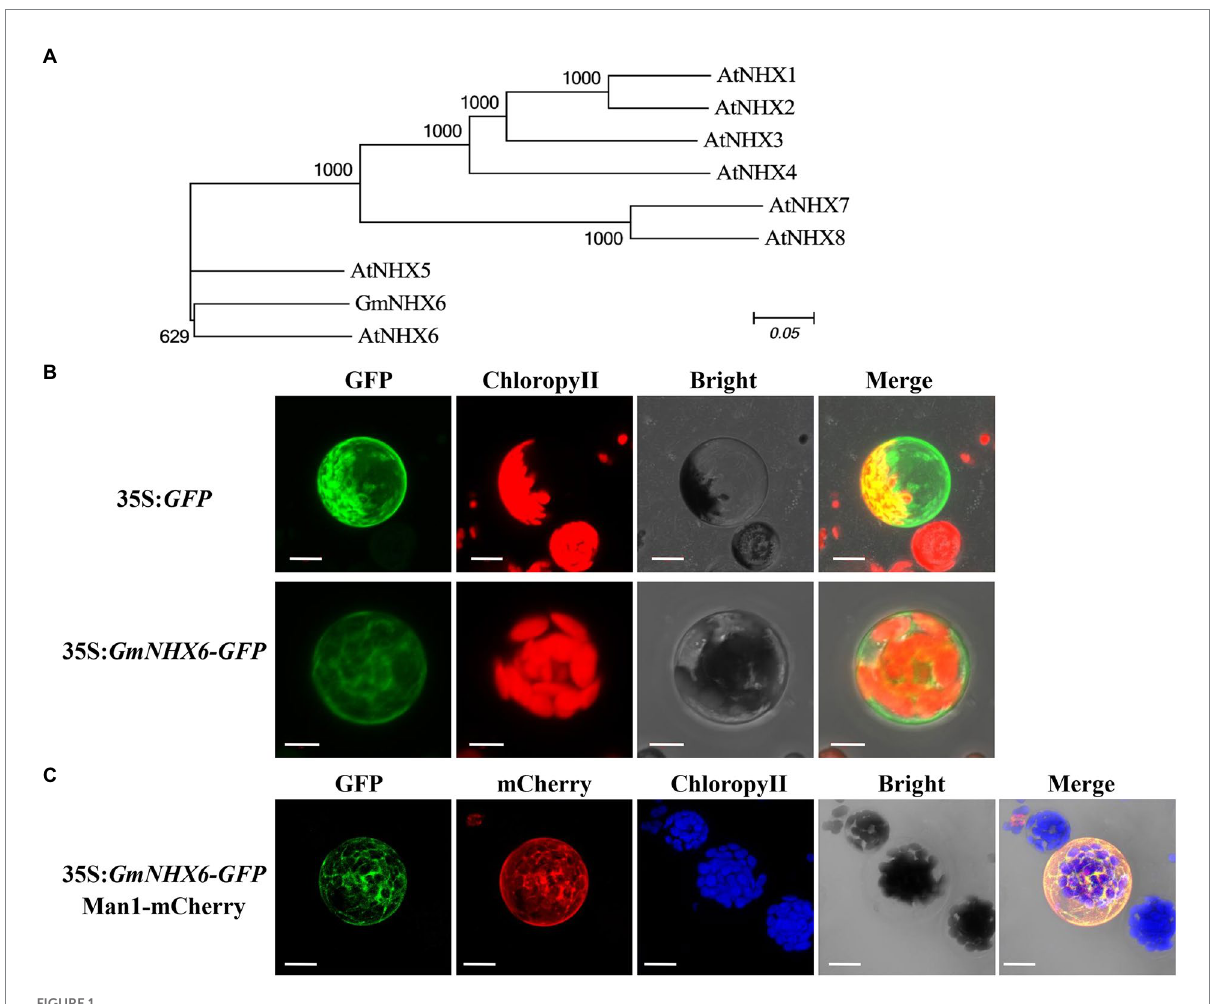
FIGURE 1 Phylogenetic analysis and subcellular localization of GmNHX6. (A) Phylogenetic analysis of GmNHX6 (XP_028181010.1) from soybean Glycine max and NHX proteins from Arabidopsis thaliana including AtNHX1 (NP_198067.1), AtNHX2 (NP_187154.1), AtNHX3 (NP_200358.1), AtNHX4 (NP_187288.2), AtNHX5 (NP_175839.2), AtNHX6 (NP_178079.2), AtNHX7 (NP_178307.2), AtNHX8 (NP_172918.2). The sequences of NHX proteins were downloaded from the Phytozome database. Unrooted phylogenetic tree was constructed using MEGA6.0 based on the Maximum Likelihood algorithm with 1,000 bootstraps. (B) Subcellular localization of GmNHX6. GFP protein and GmNHX6-GFP fusion protein expressed under the control of CaMV 35S promoter in Arabidopsis protoplasts were observed under a confocal microscope. Bar, 10 μ m. (C) Images of